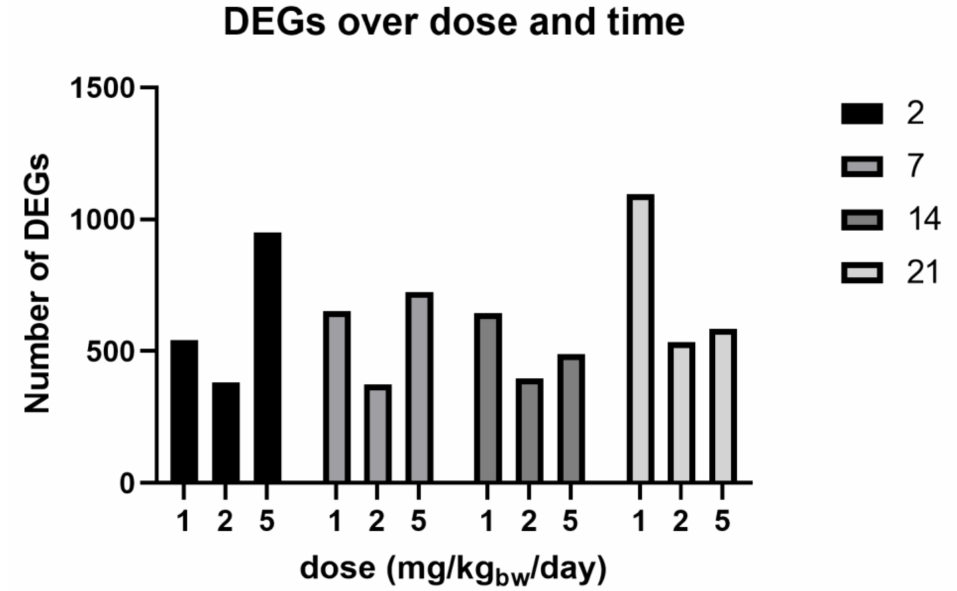
Figure 5. Number of differentially expressed genes (DEGs) after exposure to 1, 2, and 5 mg/kg bw /day of E171 in the colon of Tg mice. Bars correspond with an absolute FC ≥ 1.5. The legend indicates the days of exposure. Exposure to 1 mg/kg bw /day of E171 showed a time-dependent increase in DEGs from 2 to 21 days. A measure of 2 mg/kg bw /day of E171 continuously showed the lowest response throughout all four timepoints, while 5 mg/kg bw /day of E171 resulted in a decreasing number of DEGs with an increased exposure time. The exact number of DEGs per timepoint and dose can be found in Table 2.